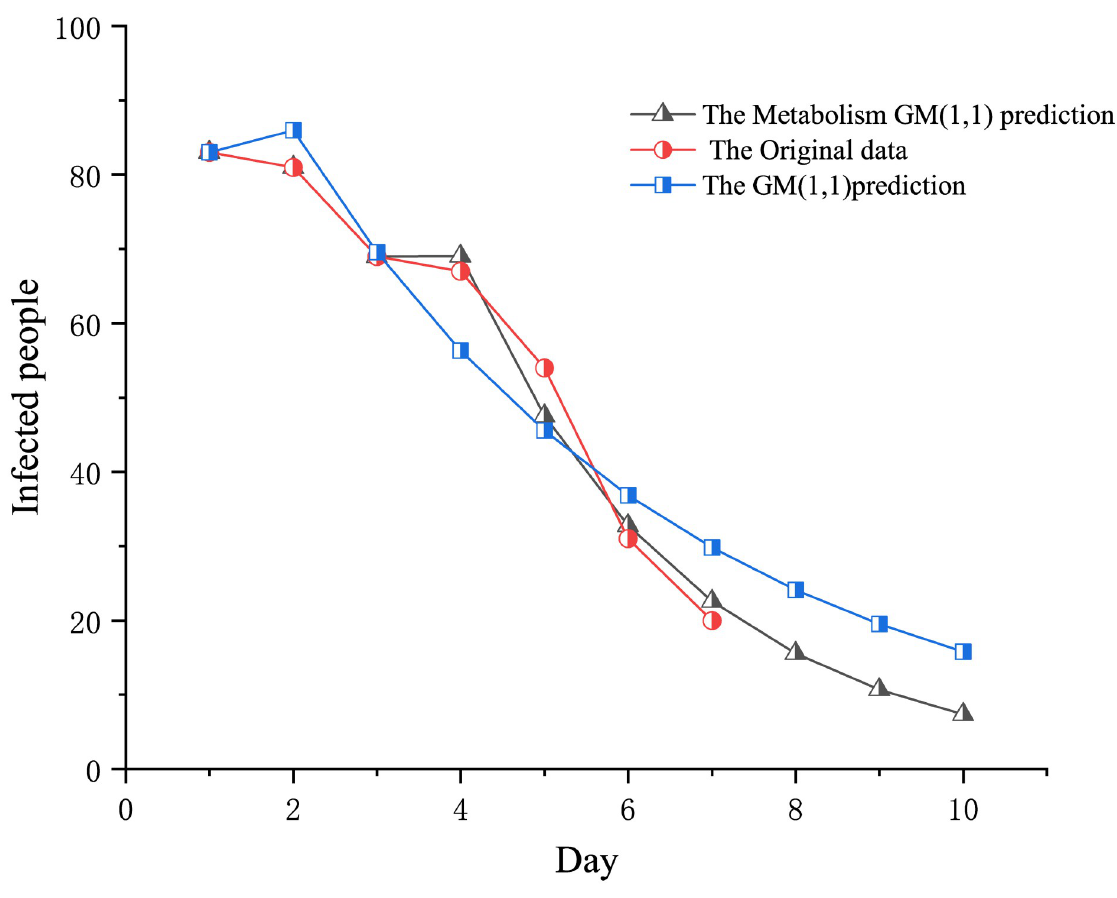
Fig 1. Infected people of